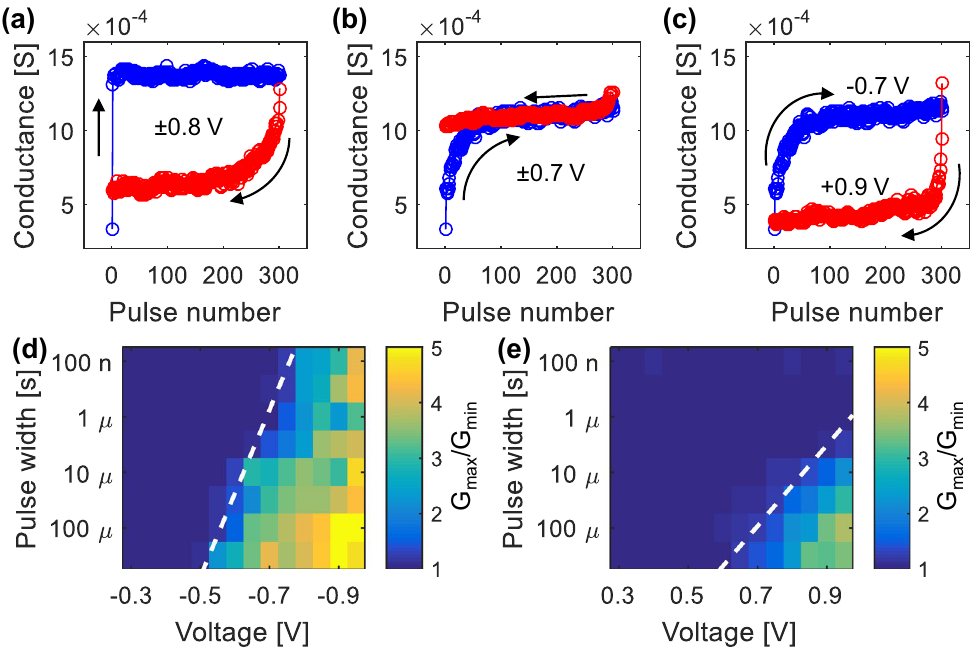
Figure 3. ( a – c ) Examples of potentiation (in blue) and depression (in red) operations to evidence the device asymmetry. Δ t is fixed at 100 μ s in all cases. The absolute Δ V is set to 0.8 V in ( a ); 0.7 V in ( b ); 0.7 V for potentiation and 0.9 V for depression in ( c ). ( d , e ) Memory windows, defined as the conductance ratio after 300 identical pulses, as a function of Δ t and Δ V for the potentiation ( d ) and depression ( e ) processes. A dashed line is added to highlight the switching threshold, defined for a minimum variation of